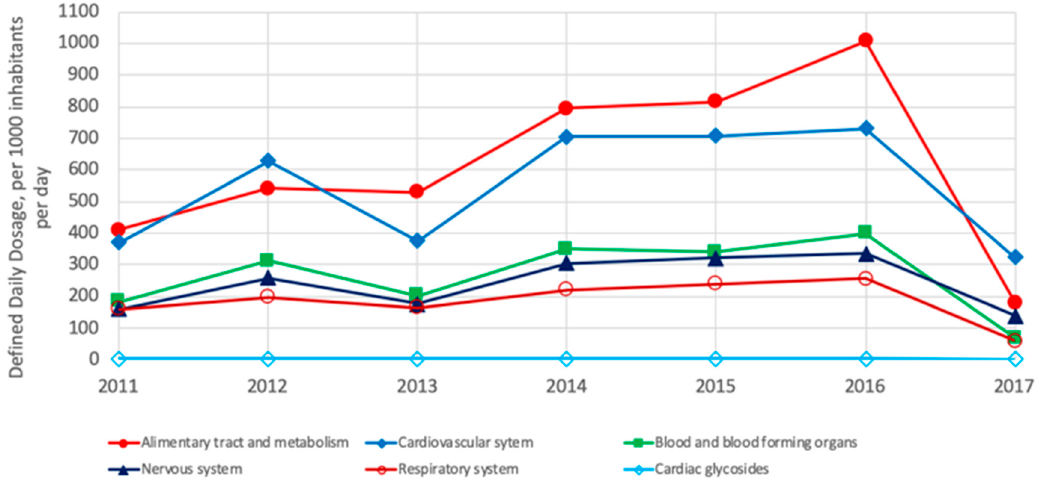
Figure 13. Most consumed pharmaceuticals in OECD Asian countries from 2011 to 2017 [3].